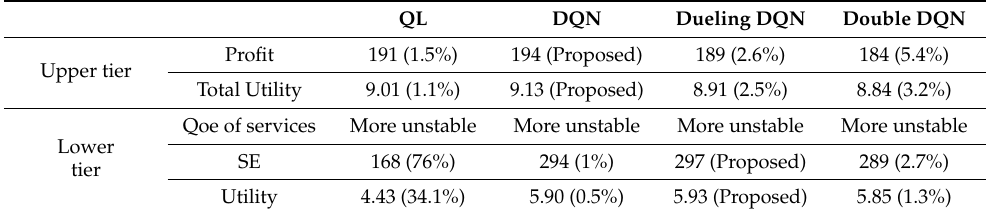
Table 4. The proposed algorithm is compared with other